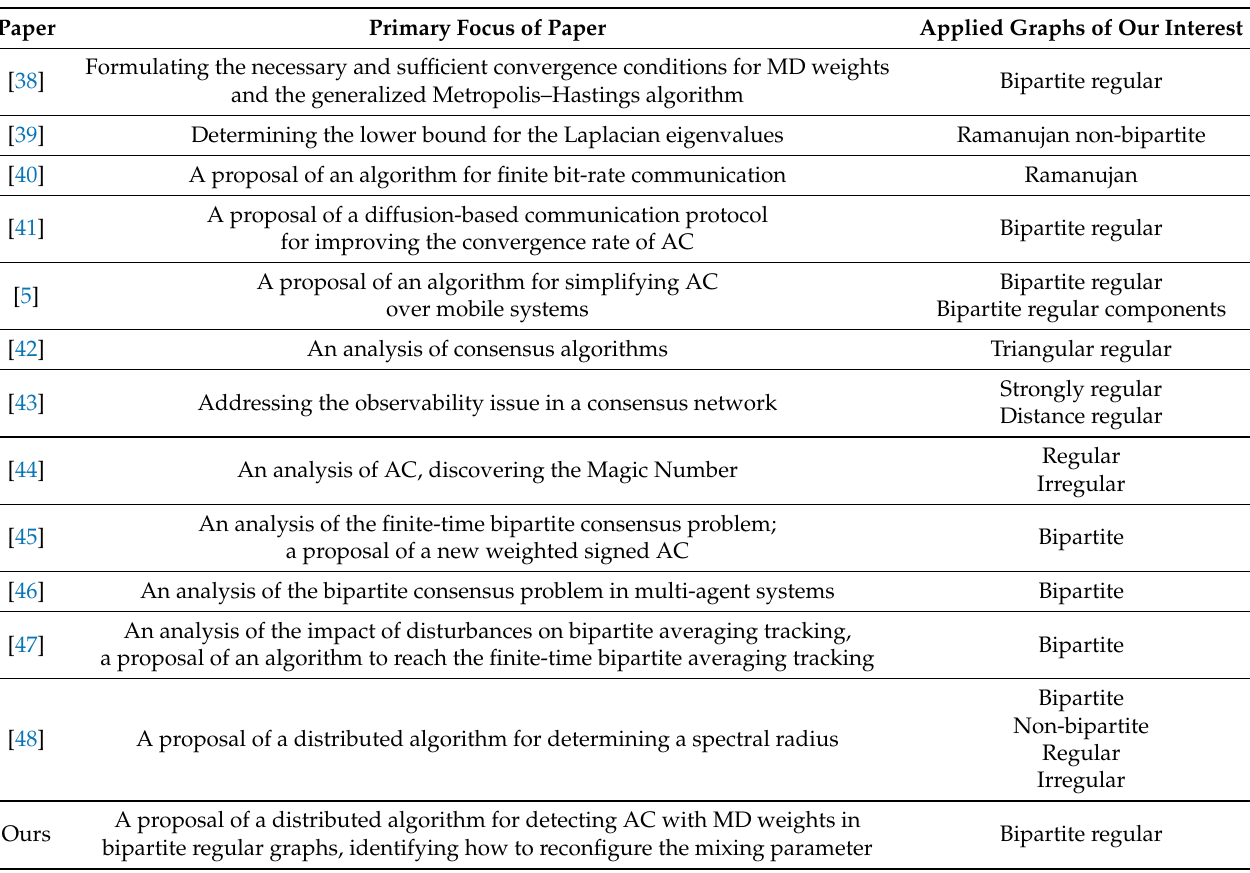
Table 1. Comparison of our approach to related